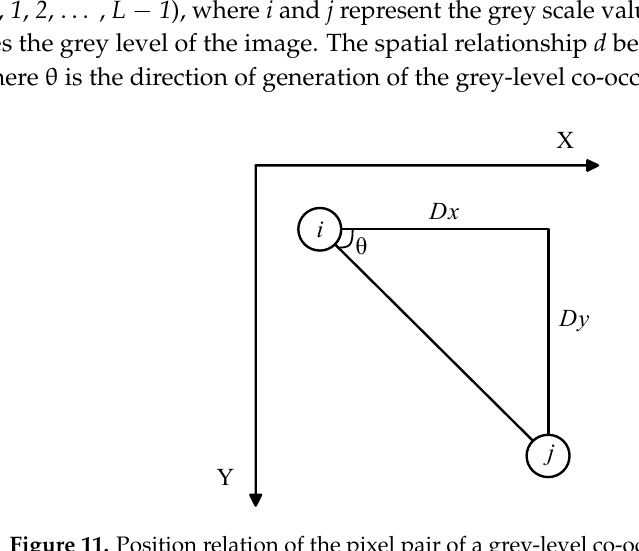
Figure 11. Position relation of the pixel pair of a grey-level co-occurrence matrix.